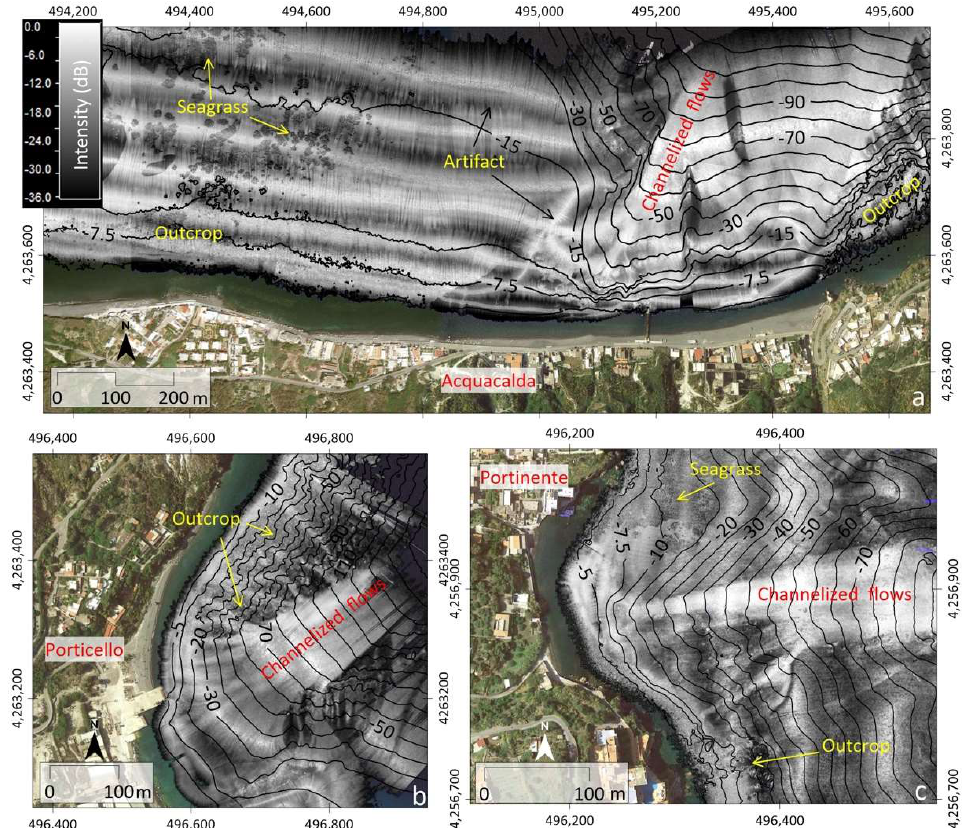
Figure A8. Backscatter mosaic of selected marine sectors in correspondence with canyon heads at Acquacalda ( a ), Porticello ( b ), and Portinente ( c ), suggesting the occurrence of channelized flows in correspondence with canyon heads. The different backscatter intensity (pale grey/white tones correspond to high backscatter values and dark grey ones to low backscatter) supports the interpretation of the nature of the seabed (outcrop vs. sedimentary cover) and the overall coarser or finer grain size of superficial sediment (see text for details).